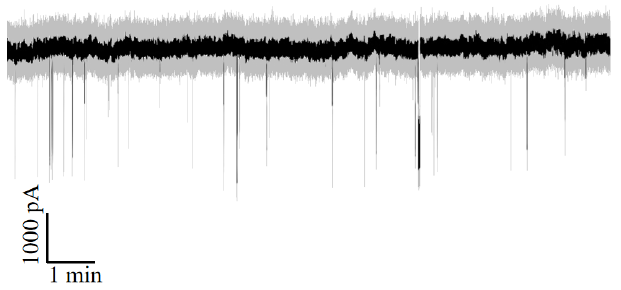
(7) Table 1. Comparison of SNR and RMSE after processing by four methods . Wavelet Decomposition and Reconstruction Method